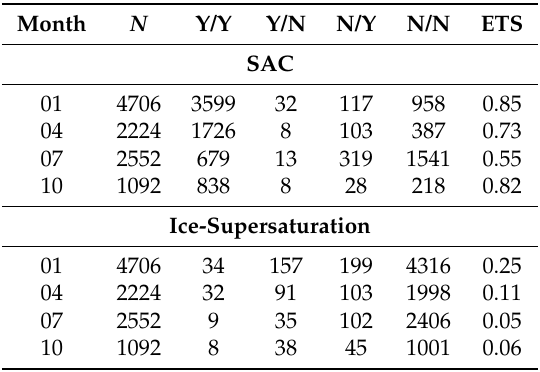
Figure 1. Comparison of contrail formation conditions expressed as relative humidity in the exhaust plume in the moment when the temperature reaches T max , for MOZAIC ( x -axis) and the corresponding ERA-5 data ( y -axis). The seasons are plotted with intuitive colours: winter (January) blue, spring (April) green, summer (July) red, and fall (October) yellow. Contrails are possible when RH max ≥ 1. Negative RH max signifies conditions warmer than the maxmimum temperature where contrails are possible (that is, the plume does not get as cold as T max ). Table 1. Entries in contingency tables and equitable threat score (ETS); Y/N means that the feature exists in MOZAIC, but not in ERA-5. N is the number of